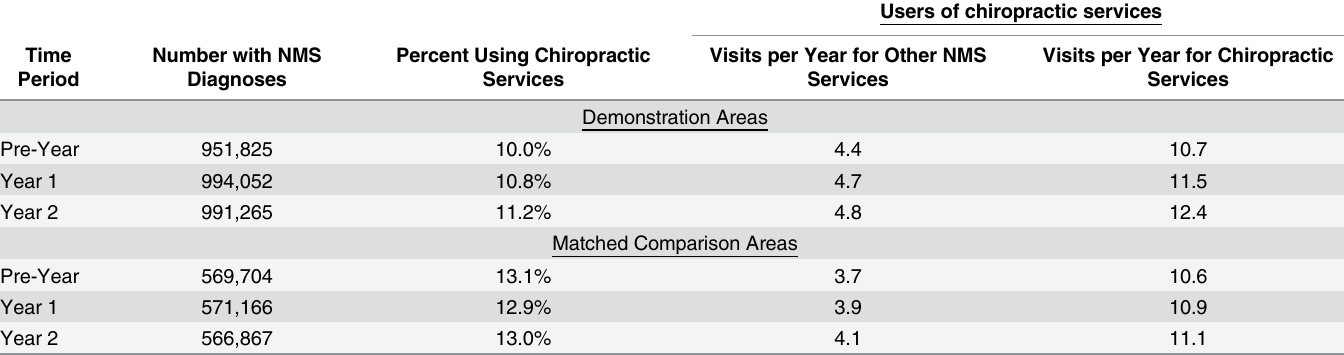
Table 1. Annual Use Rates of Chiropractic Services by Medicare Beneficiaries with Neuromusculoskeletal (NMS) Diagnoses in Demonstration and Comparison Areas.